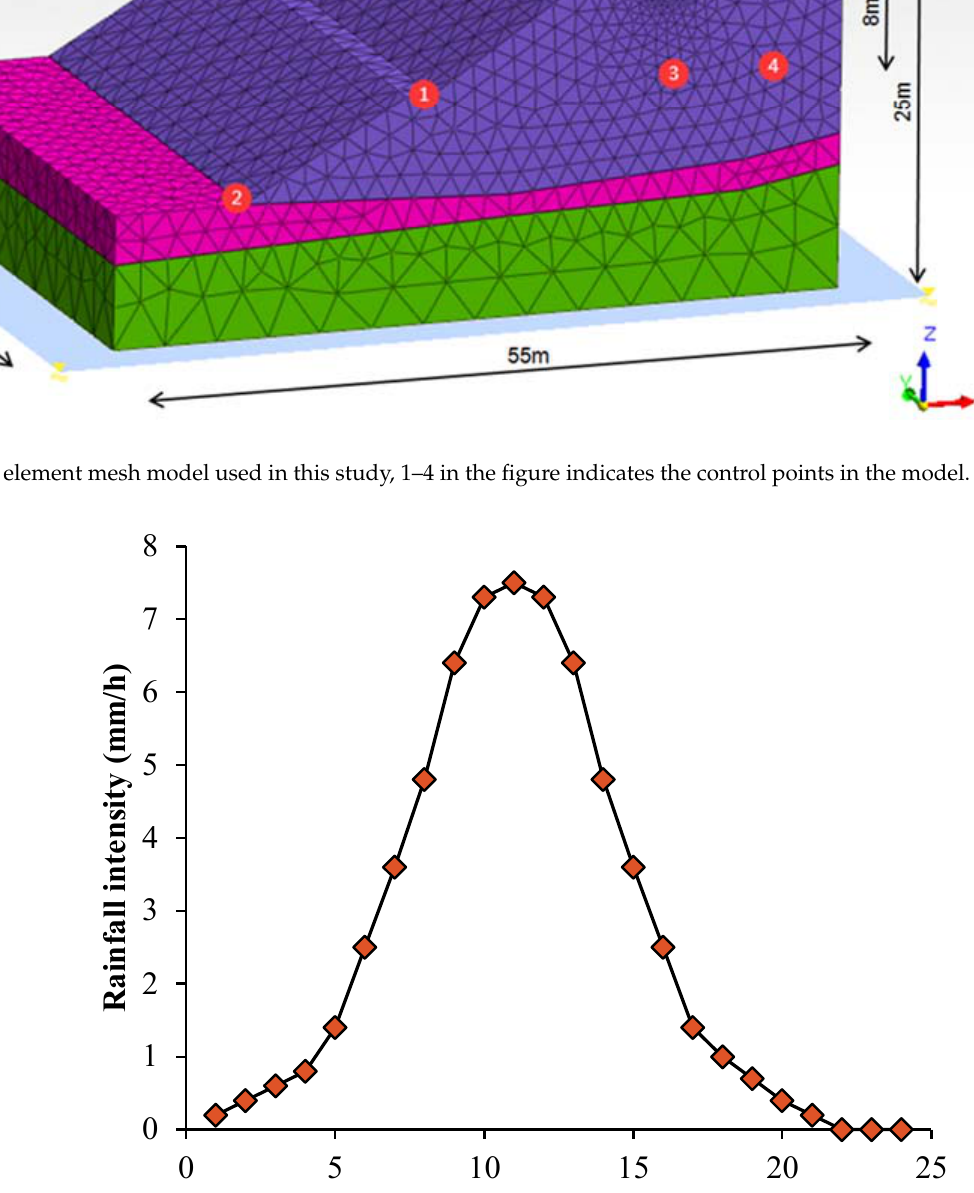
Figure 3. Rainfall intensity over time. 2.4. Model Parameters